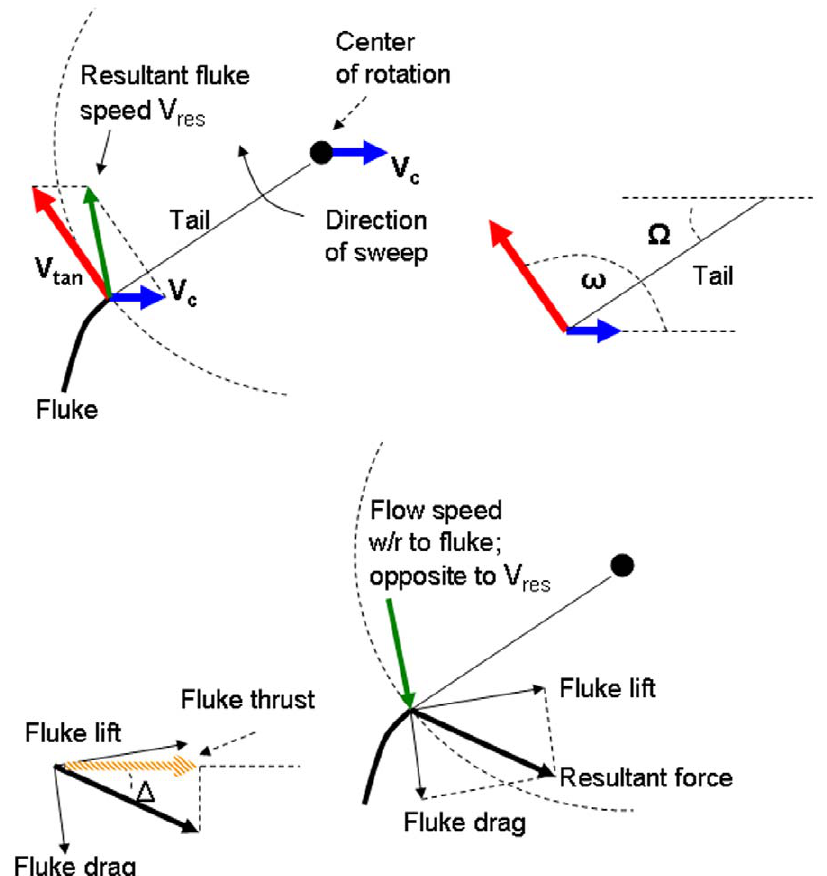
Figure 16. Simple model of the forces and velocities about the flukes.